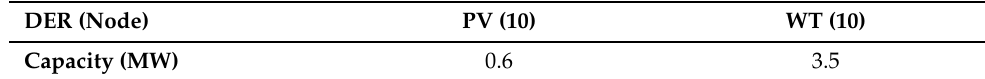
Table 2. Installed capacity of